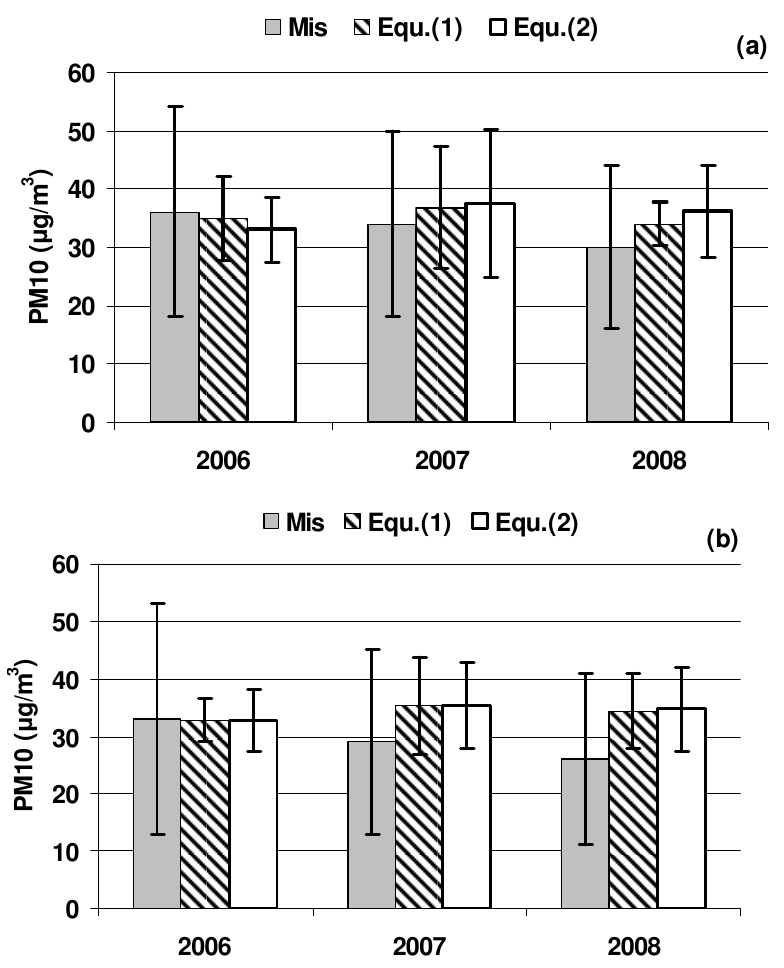
Figure 10. Yearly means ±1 SD of measured and satellite estimated PM10 mass concentrations by Equation (1) and Equation (2) at (a) Arnesano and (b)